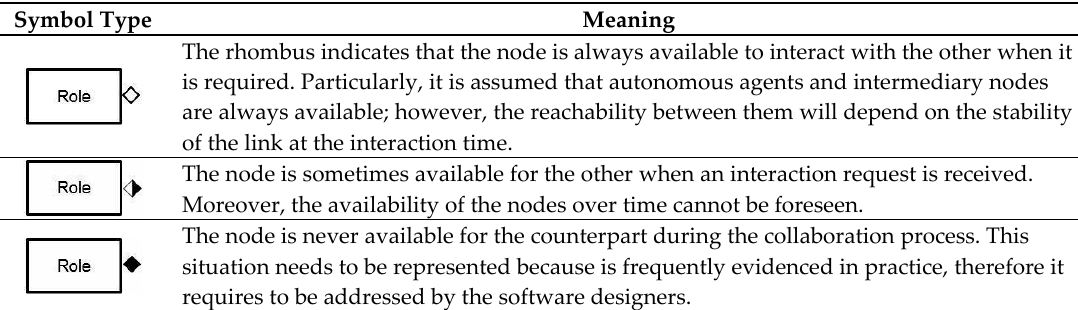
Table 4. Types of availability considered by the